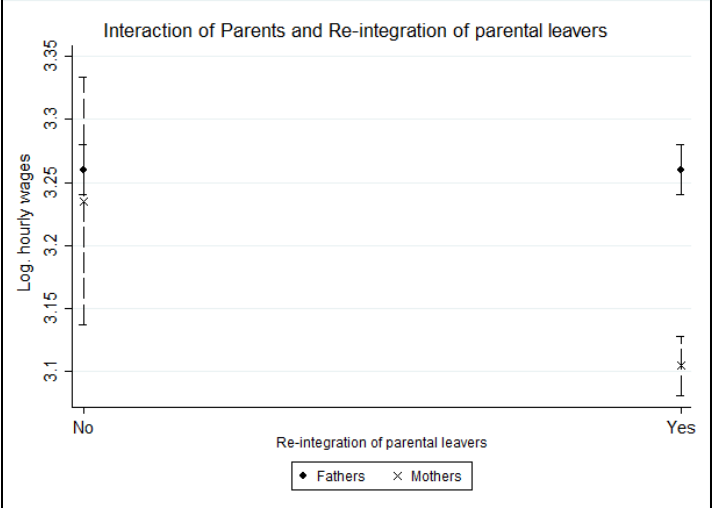
Figure 3. Log hourly wages of fathers and mothers by the offer of re-integration for parental leavers combined with EQM (predictive margins of parents with 95% CIs using Stata 14; based on Table 5) .